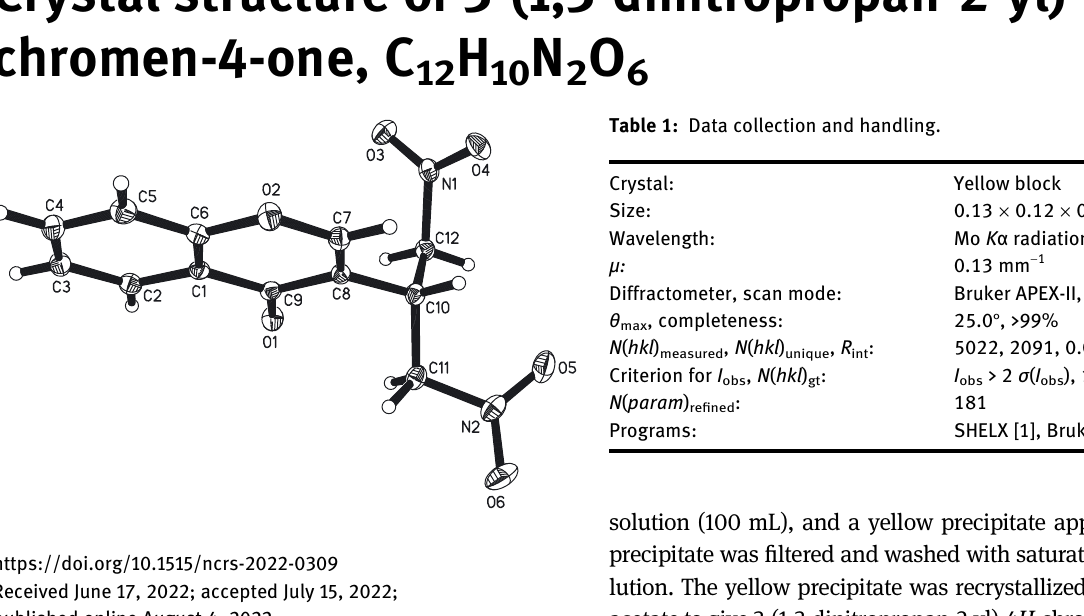
Table 1 contains crystallographic data and Table 2 contains